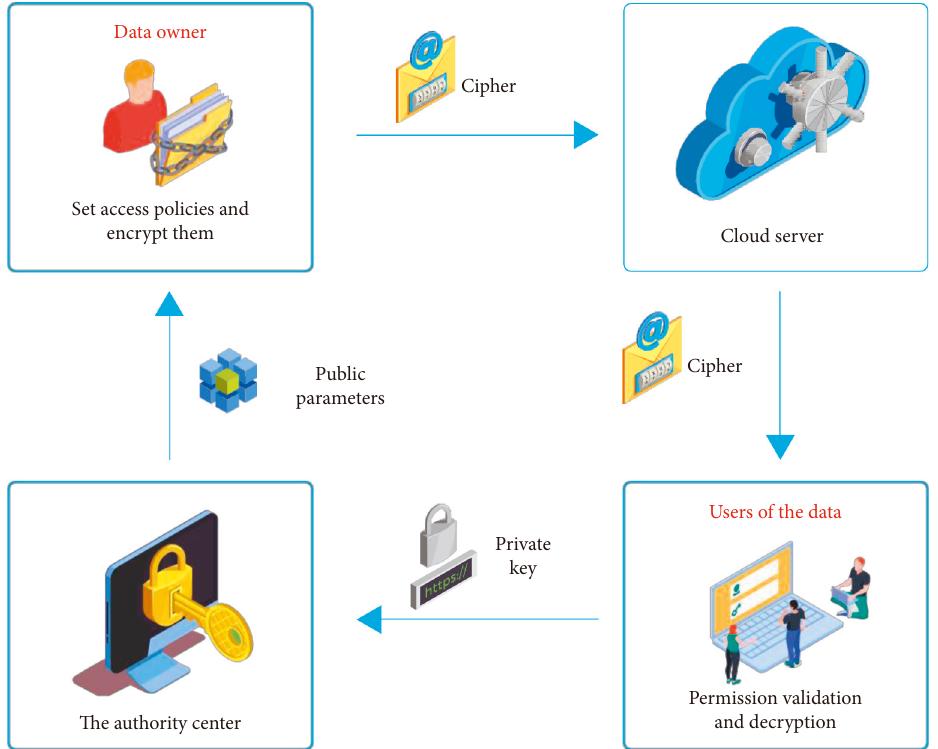
Figure 2: HP-CP-ABE solution model in cloud